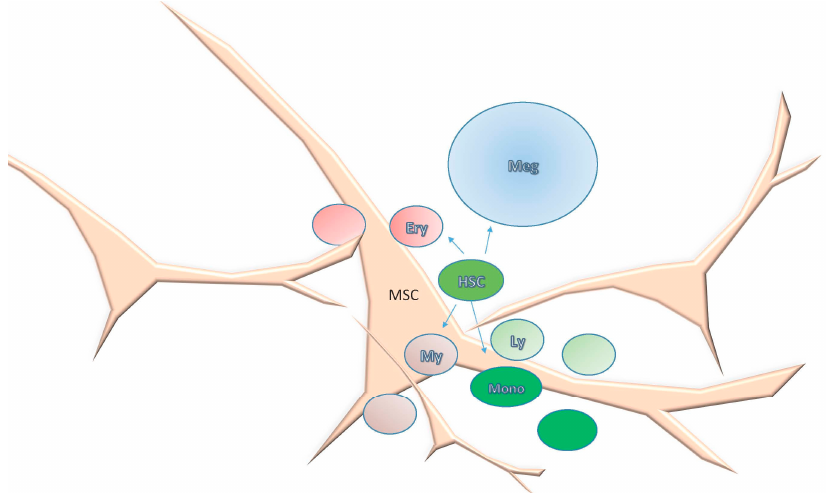
Figure 7. Model of hematopoietic differentiation within a Hematopoietic Unit (HU). Mesenchymal stromal cells (MSCs) are key components of HU; they contact hematopoietic stem cells (HSC) and their progeny as well as the other components of the stem cell niche. Differentiation occurs according to the topobiology of the progenitors, Erythroid (Ery), Megakaryocytic (Meg), Myeloid (My), Lymphoid (Ly) and Monocytic (Mono). MSCs may act as scaffolds that help progenitors to localize in particular regions and to direct their contact with other microenvironmental cells.